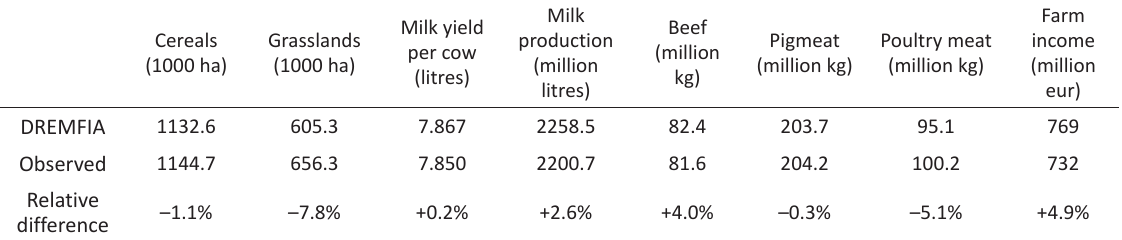
Table 2. Production quantities, crop cultivation areas and farm income in the baseline scenario and reality (“observed”: official agricultural statistics, http://www.luke.fi/en/statistics/ ); 5-year average 2008–2012. The grassland area is smaller in the DREMFIA baseline than in reality, since horses, lambs and reindeer (users of roughage) are not